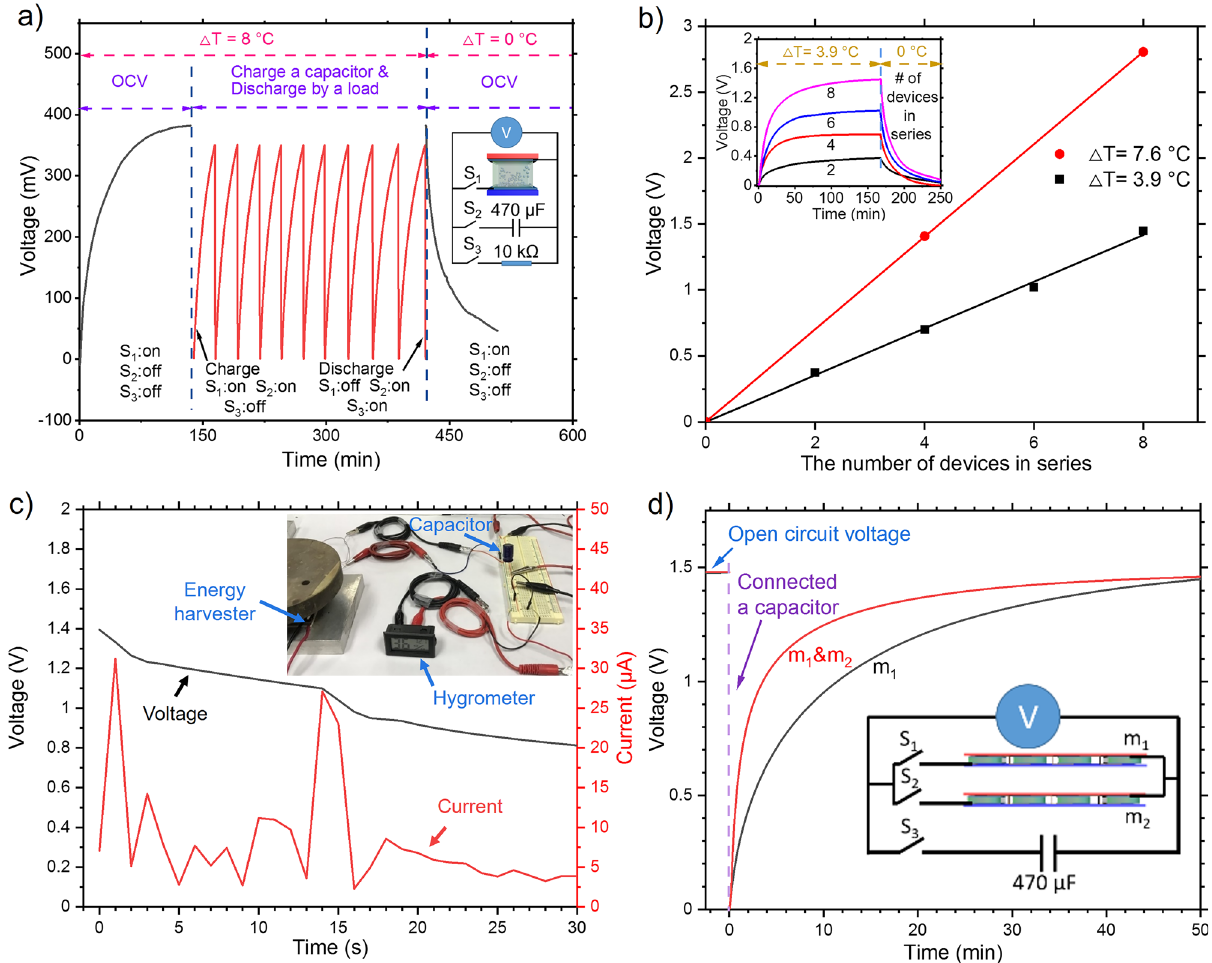
Fig. 4 Output voltage and current with multiple devices connected in series and parallel. a Voltage generation from one device under Δ T = 8 °C followed by charging/discharging a capacitor. b Linearly increasing voltage with more number of devices connected in series under Δ T = 3.9 and 7.6 °C. The upper inset is the voltage pro fi le as a function of time as 2, 4, 6, and 8 devices were joined in series. The lower inset depicts two devices connected in series. c Voltage and current pro fi les when the capacitor (470 μ F) was hooked up to the digital hydrometer shown in the inset. d Voltage pro fi les for one module (m 1 ) and two modules connected in parallel (m 1 and m 2 ), followed by charging a capacitor (470 μ F) as a function of time under Δ T = 7.6 °C. Each module consists of 4 devices connected in